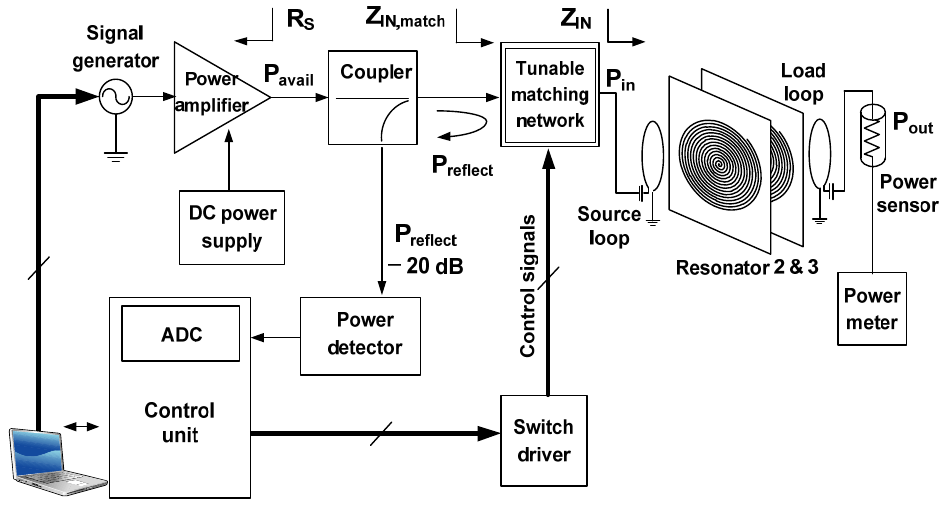
Figure 9. Block diagram of the proposed WPT